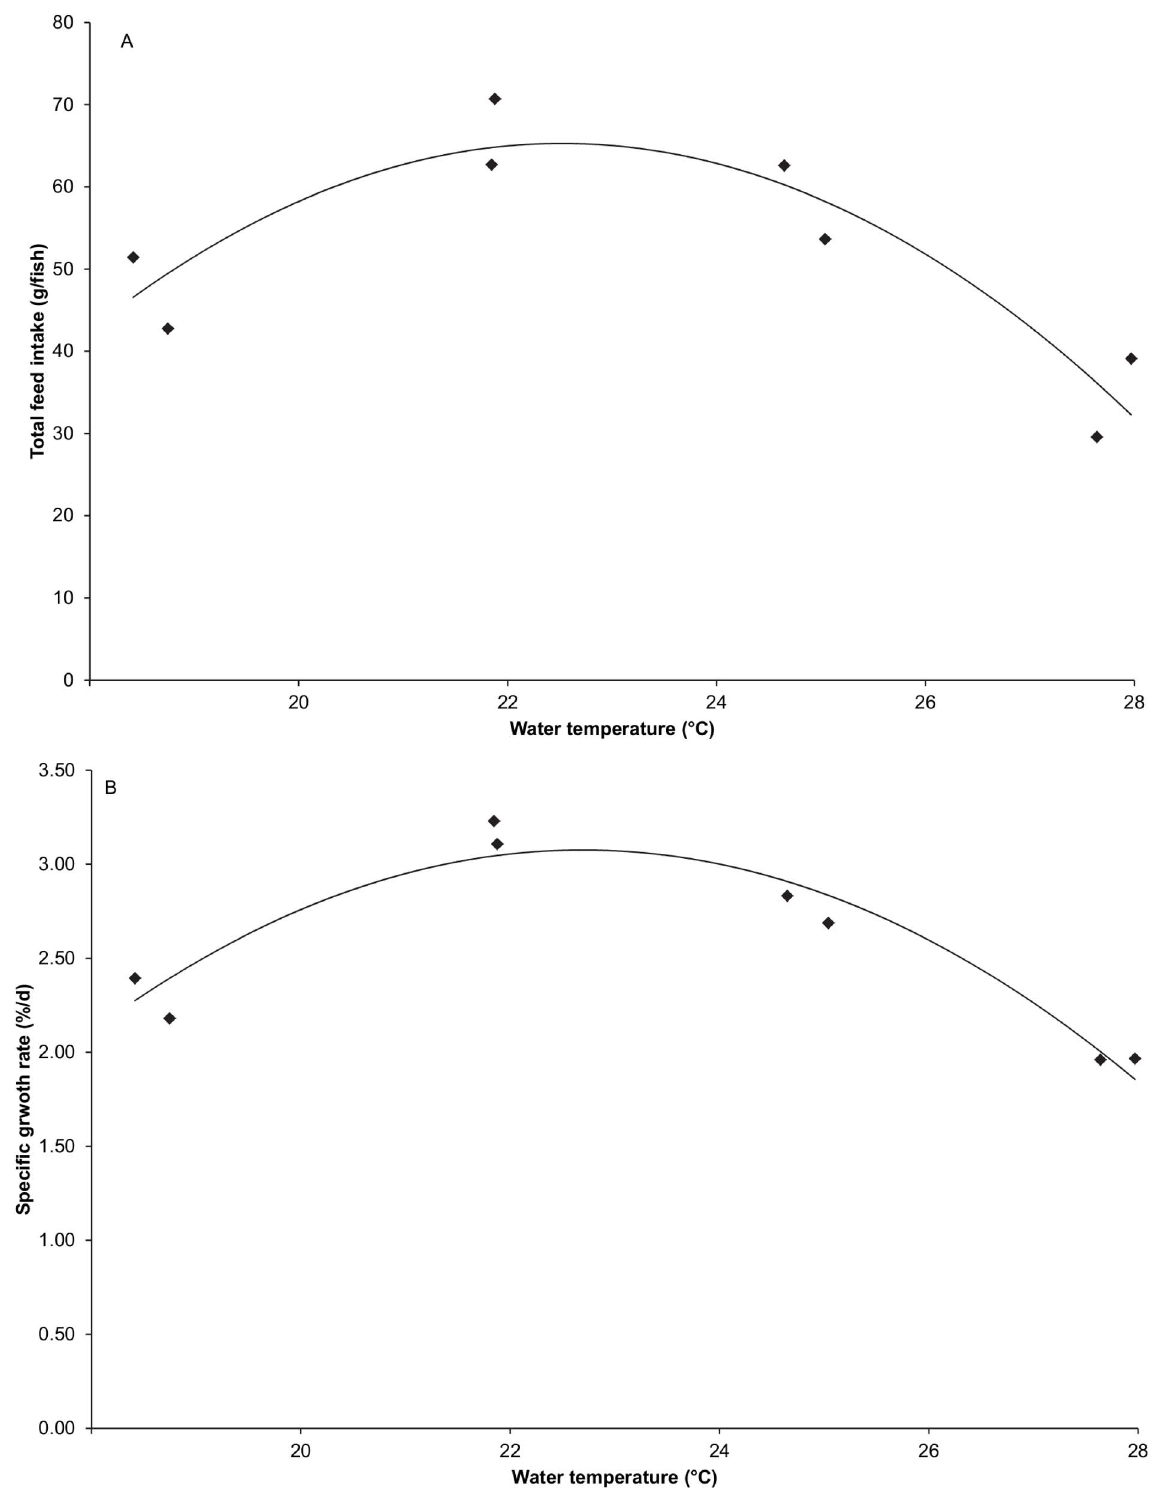
Figure 6. Total feed intake and specific growth rate of juvenile Dover sole ( S.solea ) in relation to water temperature. Total feed intake (A) (TFI, g/fish) peaks at 22.5 u C. Total feed intake (g/fish) TFI= 2 1.111.T 2 + 50.T 2 498 (polynomial regression analysis, model p-value=0.012, r 2 =0.77). Specific growth rate (B) (SGR, %/d) peaks at 22.5 u C. SGR= 2 0.044.T 2 + 1.99.T 2 19.5 (polynomial regression analysis, model p-value=0.002, r 2 =0.89). T=water temperature ( u C).